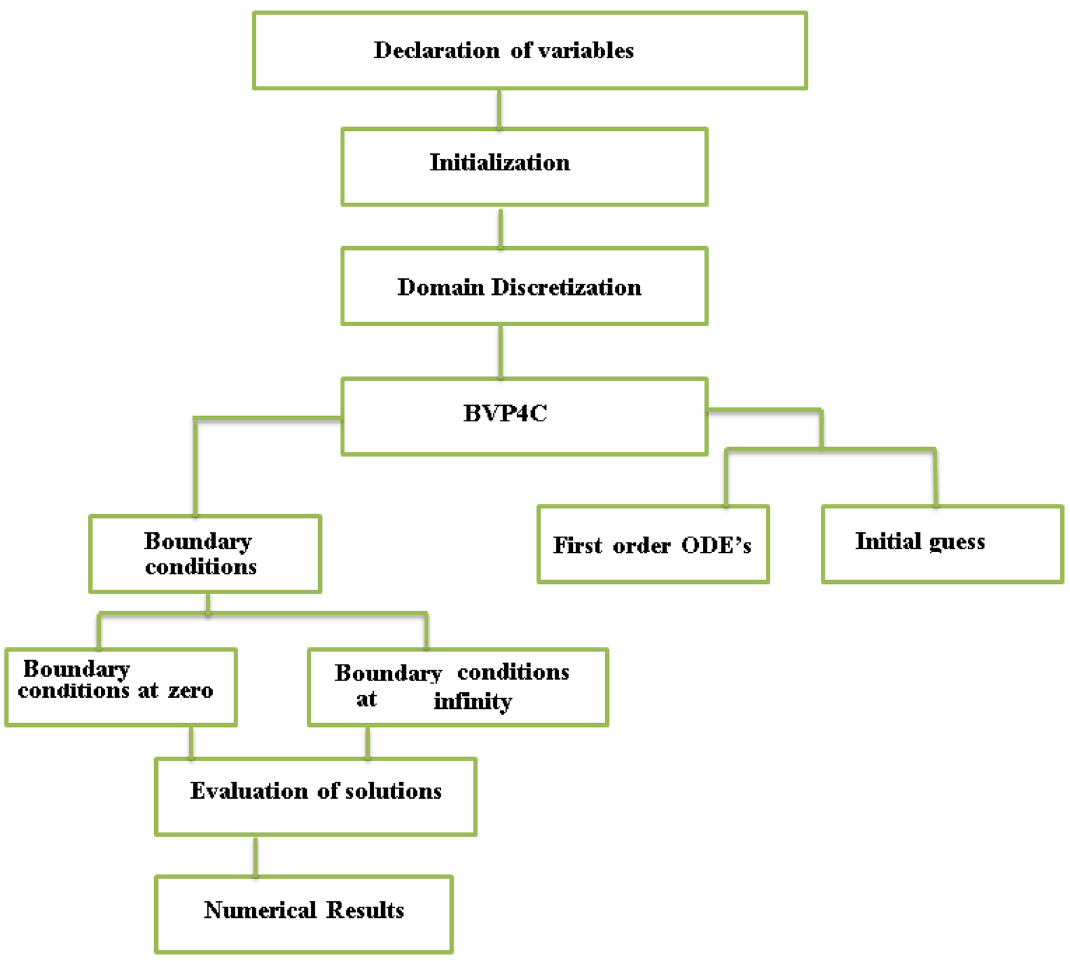
Figure 3. Flow chart of the numerical scheme.